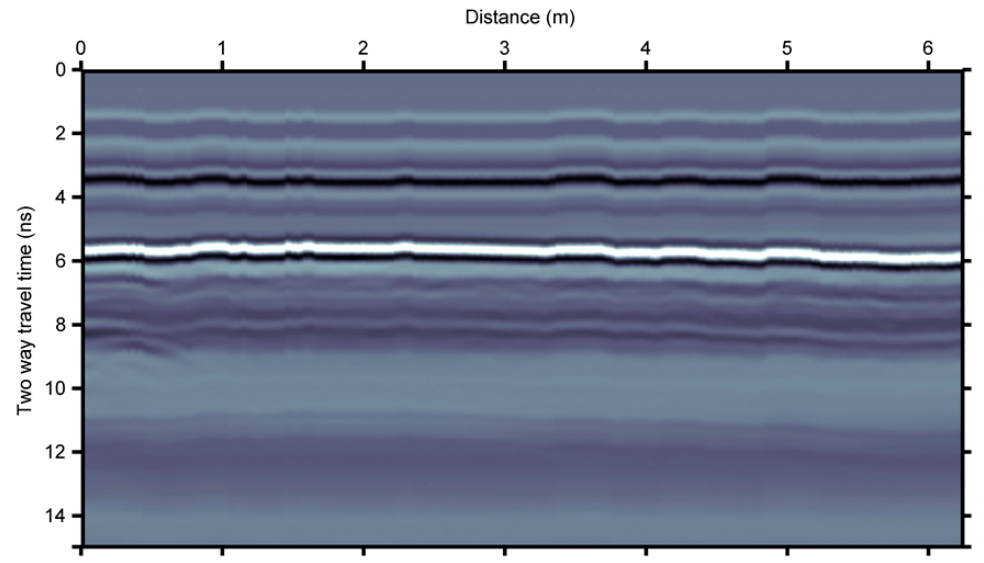
Figure 3. Raw GPR data collected by the HI-Pave HR system, manufactured by IDS S.p.A., equipped with an air-coupled antenna.